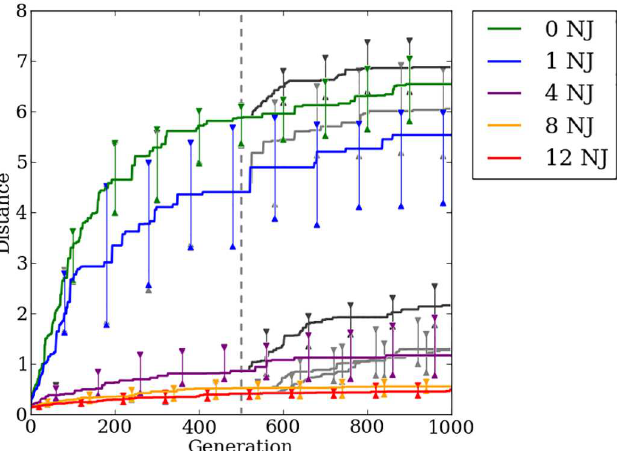
Fig 16. The median fitness for HyperNEAT and Preset-Switch-HybrID generation champions over 1,000 generations on the quadruped robot experiment. The line colors indicate the number of noisy joints on the robot. Preset-Switch-HybrID treatments divergefrom HyperNEAT treatments at 500 generationsand are gray. 95% bootstrappedconfidence intervals of the median are shown every 100 generations.